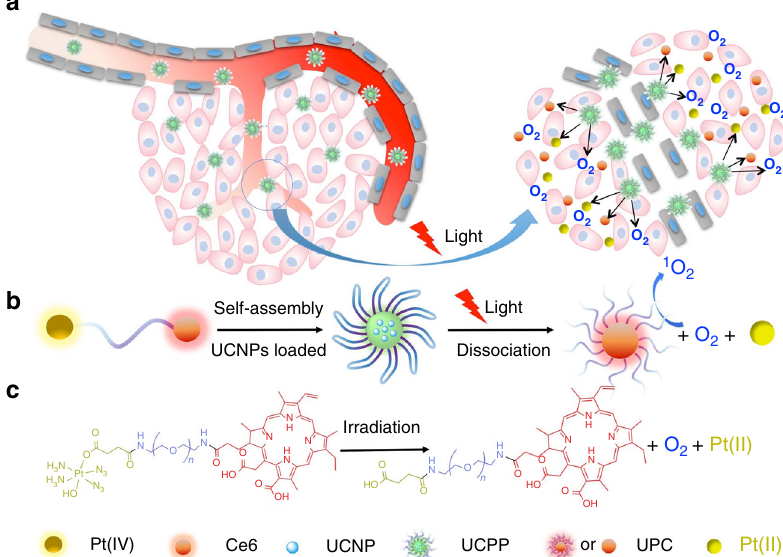
Fig. 1 Schematic illustration of UCPP nanoparticle. a A scheme illustrating the light-driven dissociation of UCPP in tumor microenvironment. b Formation of UCPP and its light-driven dissociation including O 2 self-generation, simultaneous activation of PDT, and active Pt(II) releasing for the synergistic photo- chemotherapy. c The chemical dissociation mechanism of UCPP (for details refer to ref. 27